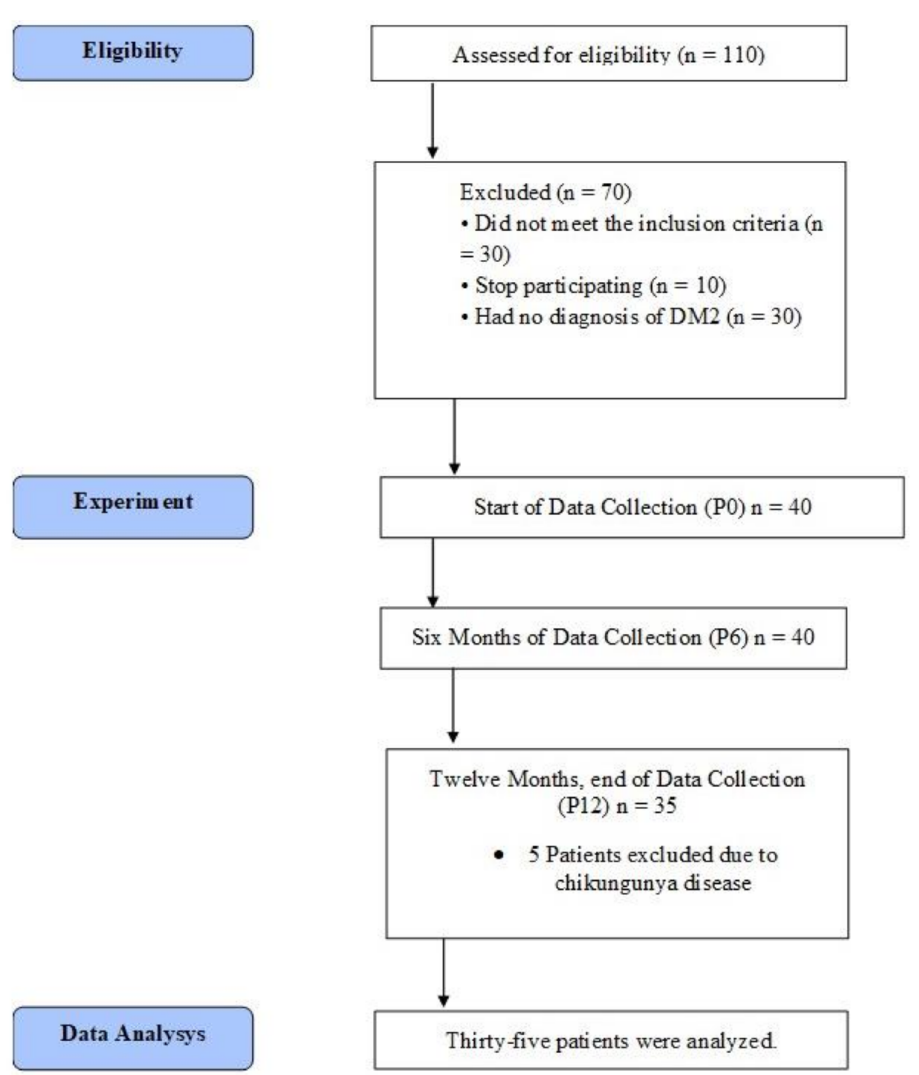
Figure 1. Data Collection